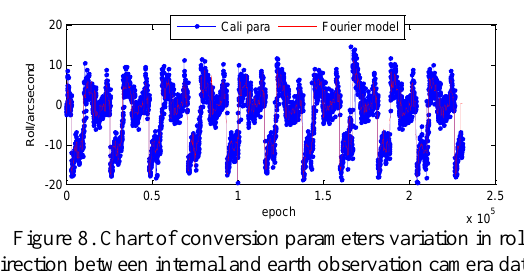
Figure 5. Chart of conversion parameters variation in roll direction between AB and BC datum